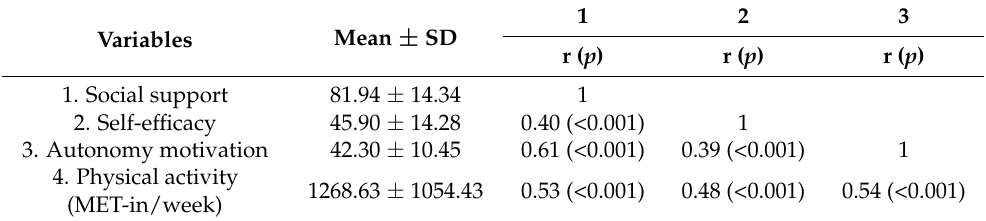
Table 2. Descriptive statistics and correlations among the variables in the study (N = 190).